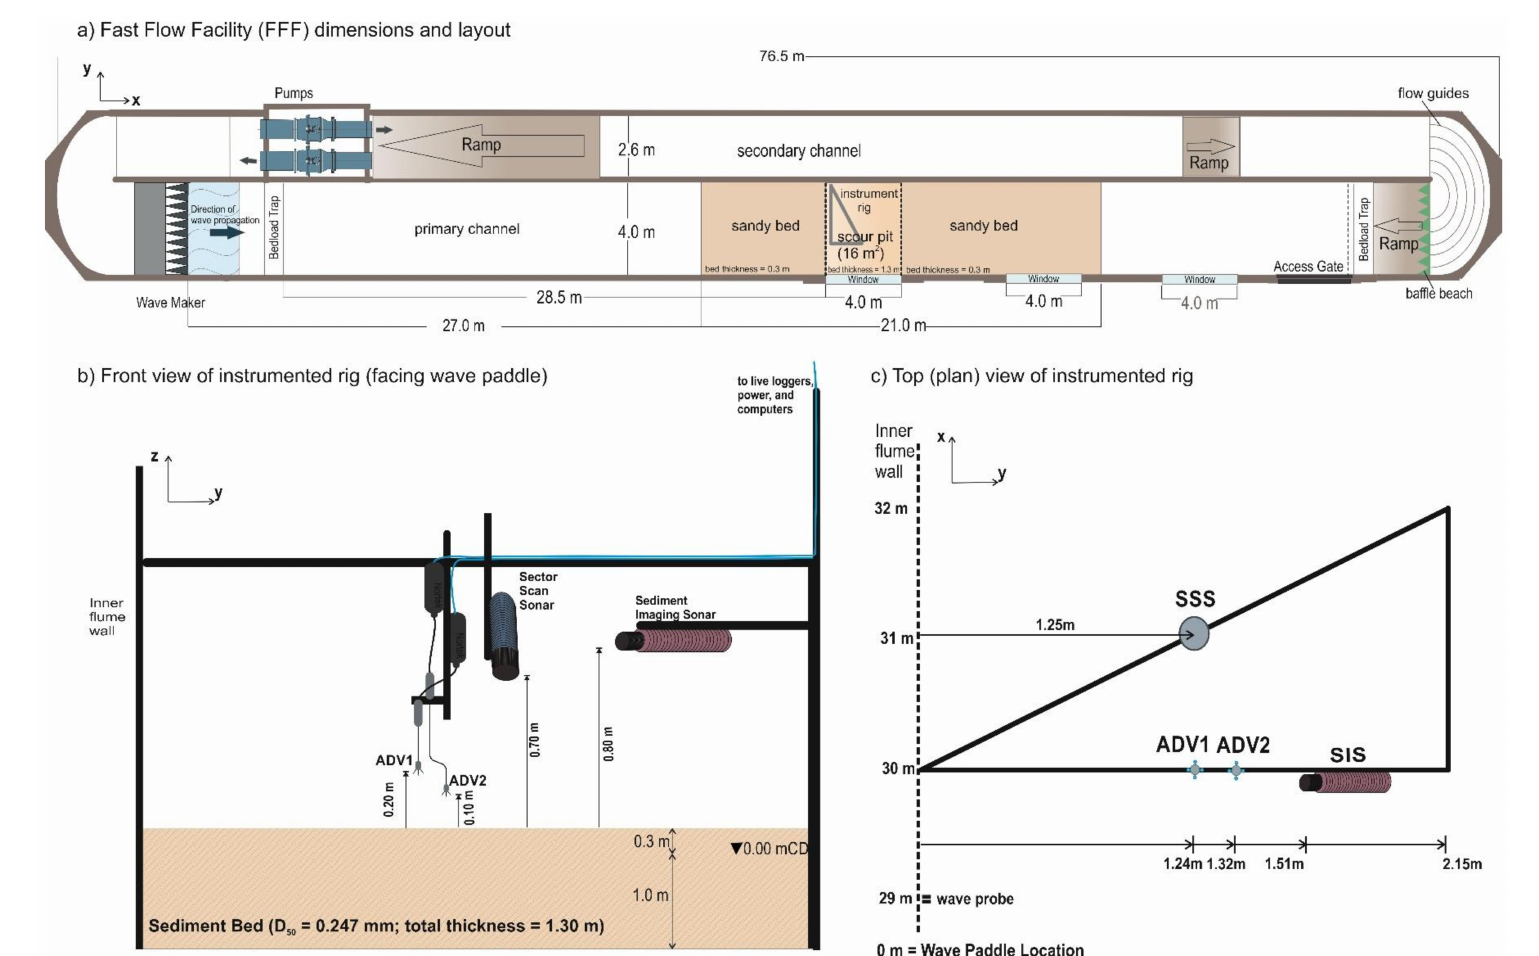
Figure 2. ( a ) Layout and dimensions of the Fast Flow Facility, showing the wave paddle, the sandy bed section and the scour pit within the primary channel, and the two pumps in the secondary channel; ( b ) cross-sectional view of the instrumented frame showing instrument configuration and vertical o ff sets; ( c ) plan view of the instrumented frame with distances from the central flume wall. ADV: acoustic Doppler velocimeter, SIS: sediment imaging sonar, SSS: sector scanning